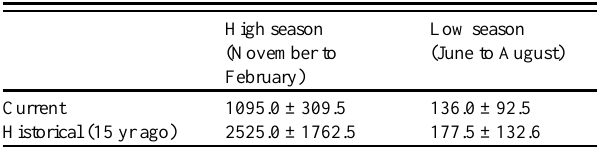
Table 2. Average reported daily catch/lancha-boat (kg) at Zalala